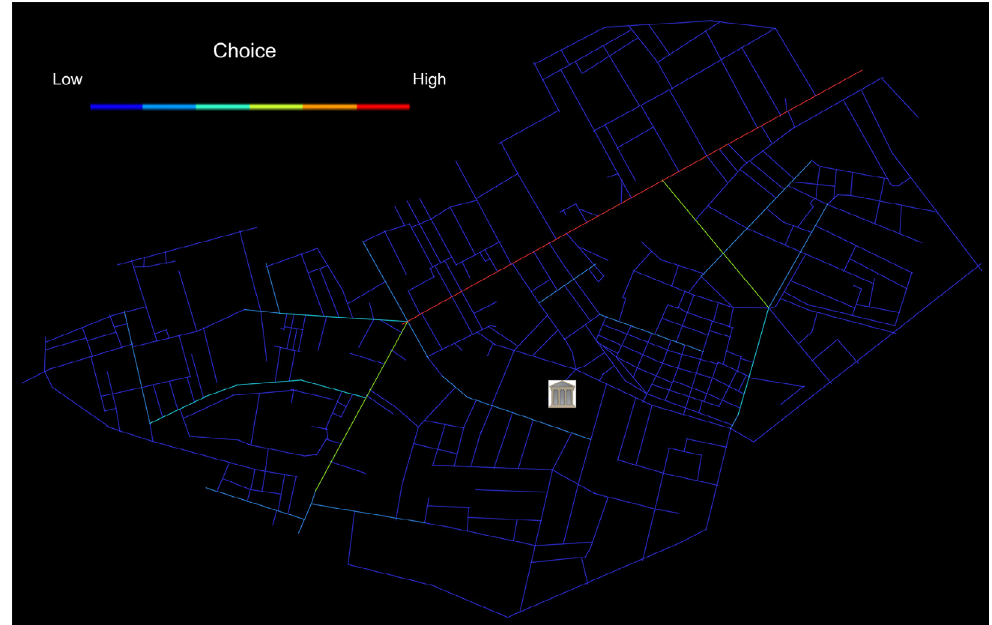
Figure 3. The Campo della Magna Mater on an axial graph, which shows the calculation of choice (radius n, 385 street segments). Streets shown in red have the highest choice, or movement potential. Streets shown in blue have the lowest choice value.